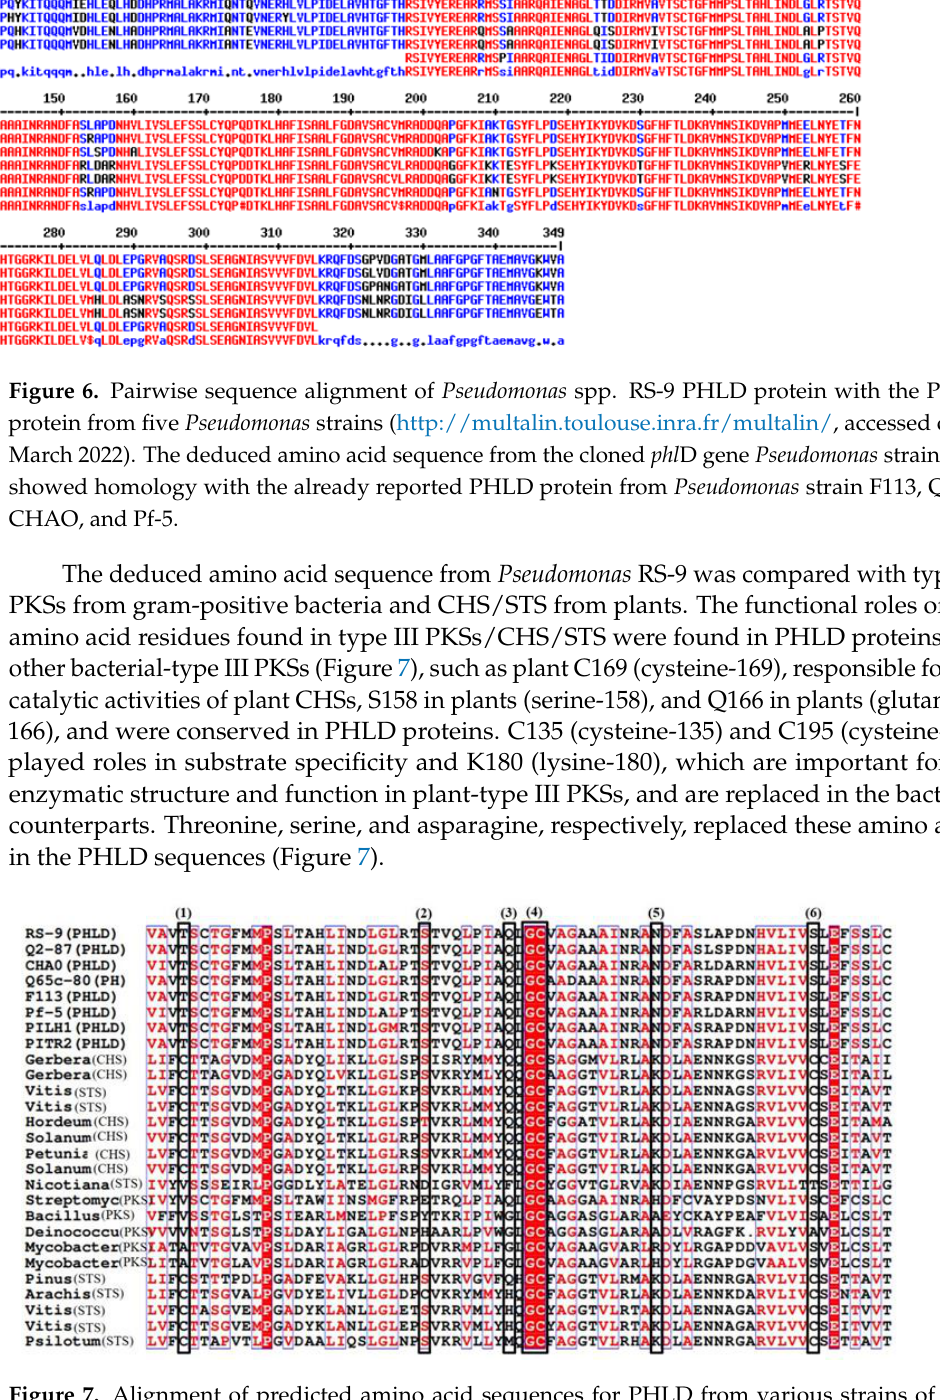
Figure 5. Pairwise sequence alignment of the cloned phl D gene (RS-9) with the reported DAPG producing the phl D gene from Pseudomonas strains from the database (http://multalin.tou- louse.inra.fr/multalin/, accessed on 15 March 2022). Our cloned phl D gene from the RS-9 strain showed homology with already reported phl D genes from Pseudomonas strain F113, Q2-87, CHAO, Pf-5, Q65c-80, PILH1, and PITR2.